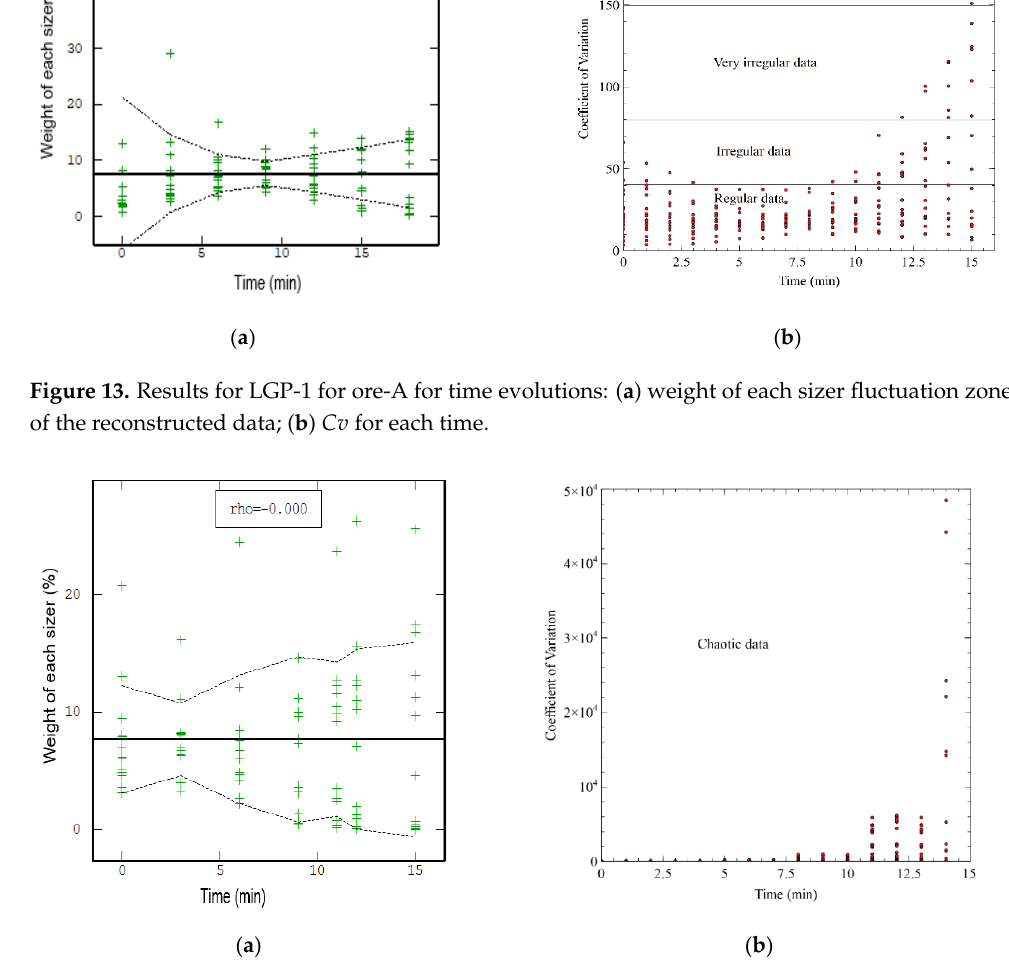
Figure 15. Coefficient of variation for LGP-1 for ore-A: ( above ) weight of each sizer, and ( bottom ) average of 𝐶𝑣 for each grinding time. 3.5. Final Report As presented in the methodology descriptor, the final report has all the information obtained from all the analyses obtained, being, in this case, the contents of all the different analyses, observations, and conclusions that were reported.